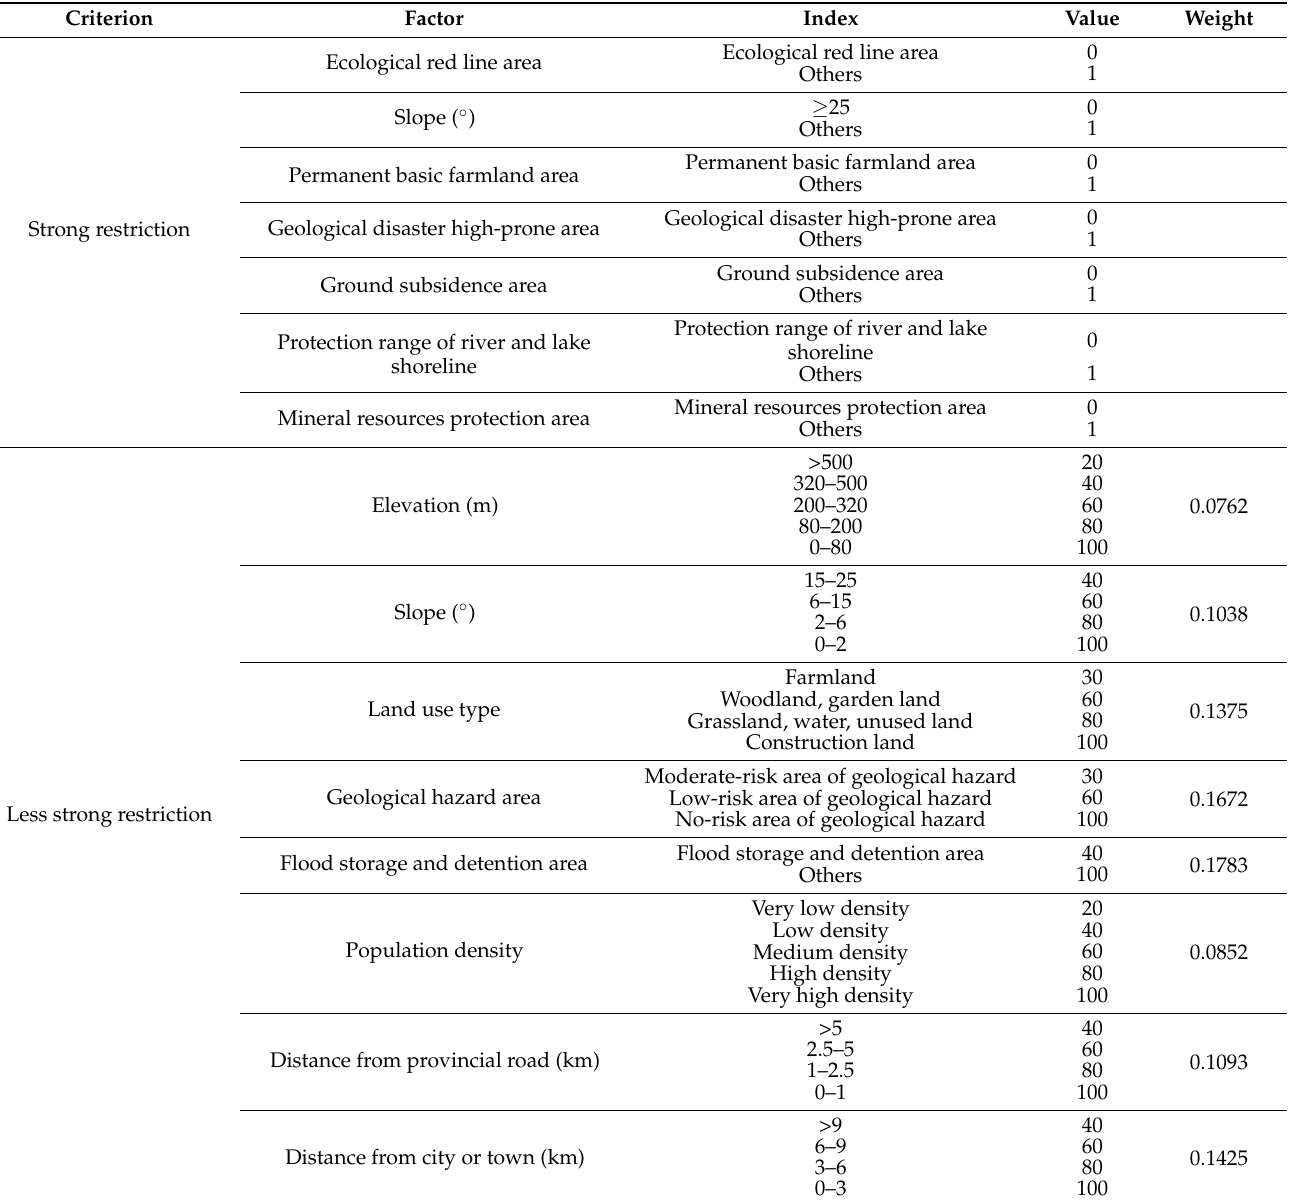
Table 1. Evaluation indices of land suitability for urban–rural construction in the study